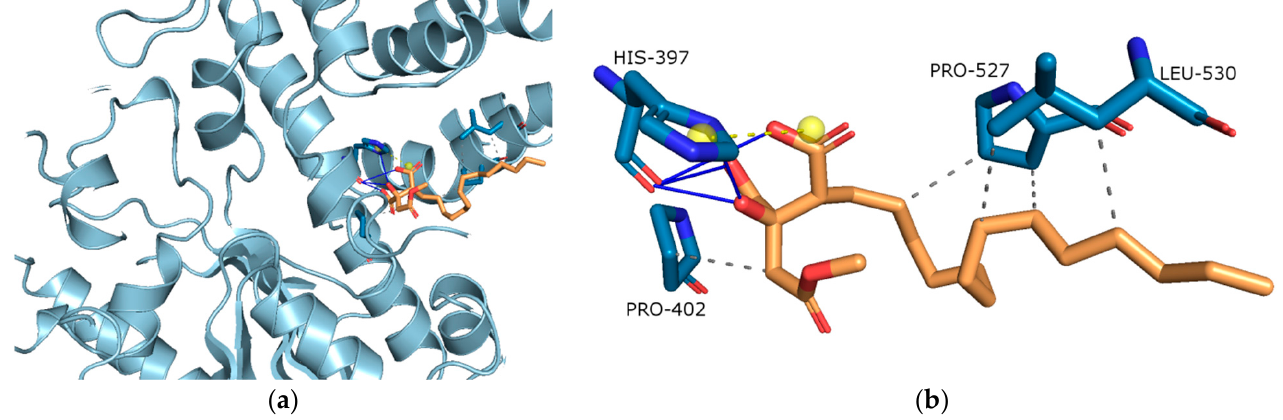
Figure 3. ( a ) Active site gorges of human acetylcholinesterase (AChE, PDB id: 4M0E); ( b ) Proposed binding mode of caperatic acid with AChE. The key interactions of caperatic acid with residues in the active sites of AChE. Hydrophobic interactions (grey dashed lines).